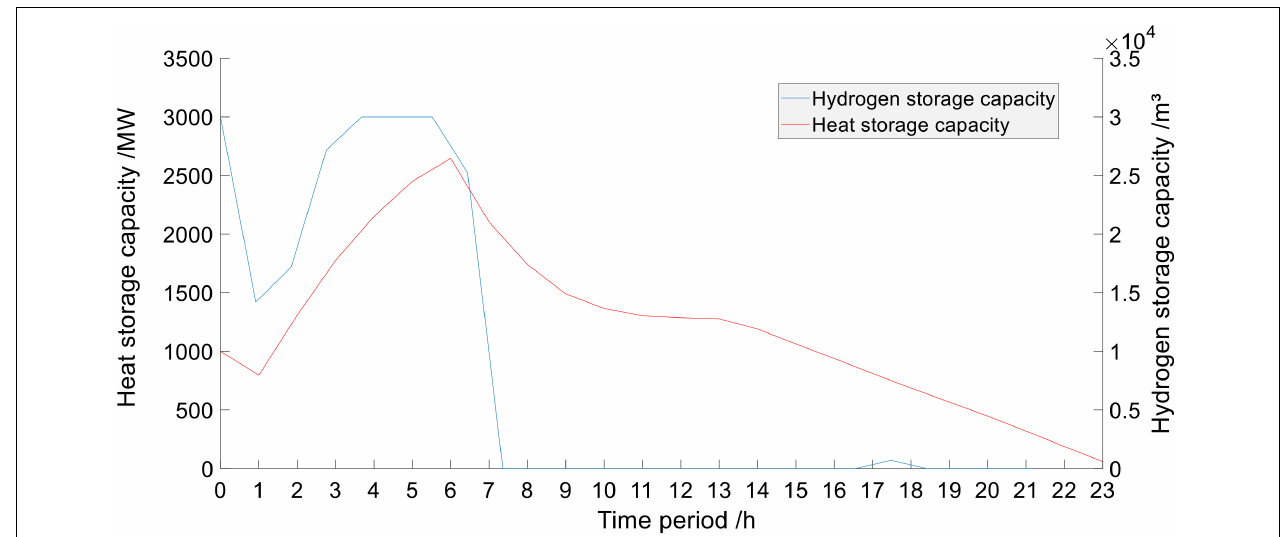
FIGURE 13 | Changes in capacity of the hydrogen storage unit (HSU) and thermal storage unit